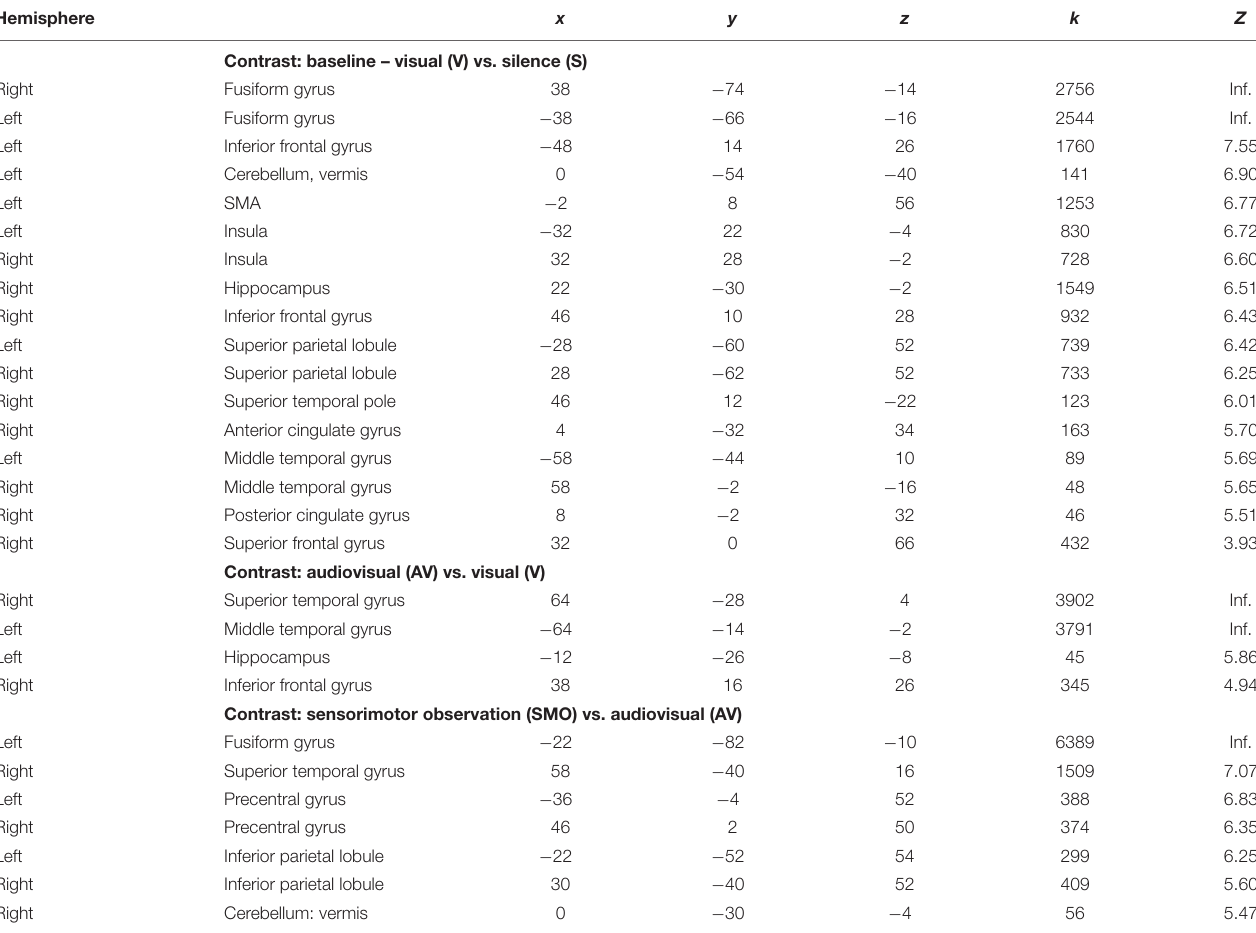
TABLE 2 | Brain areas activated in the different encoding conditions. Hemisphere